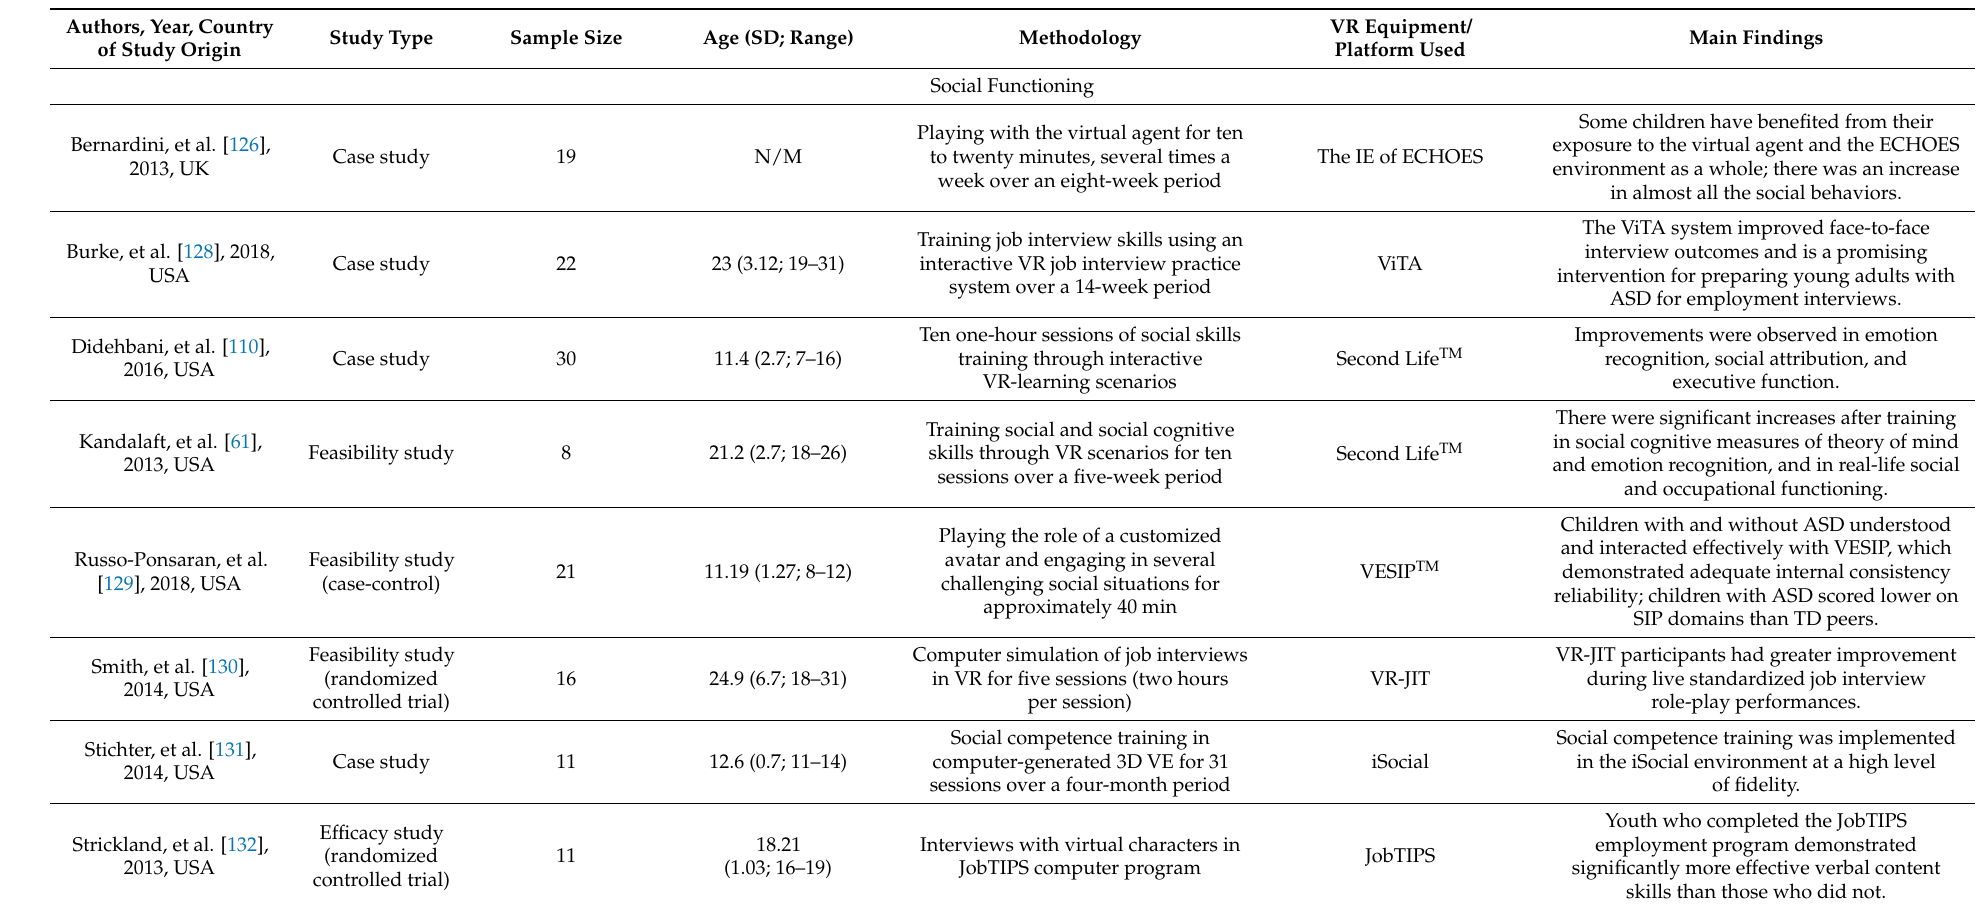
Table 2. Empirical studies reviewed on VR applications in ASD assessment and